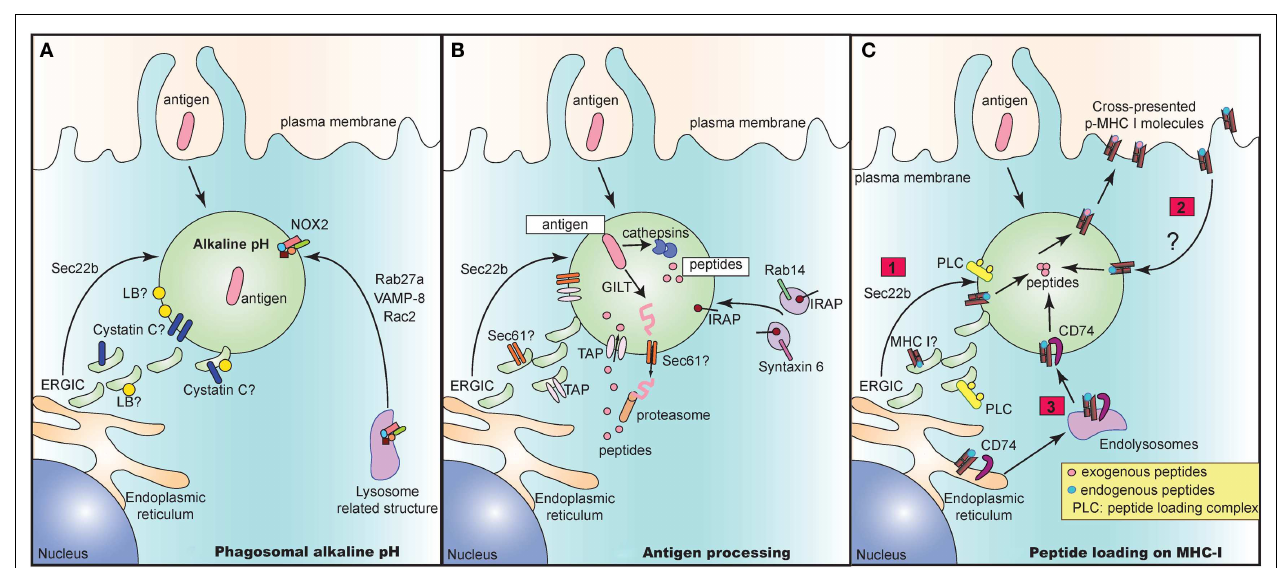
could be present in ERGIC, thereby recruited to the cross-presenting compartment via Sec22b. Once in the cytosol, antigen is then degraded into peptides and shuttled back into the phagosome via phagosomalTAP.TAP is dependent on Sec22b for its recruitment from ERGIC to endocytic compartments. Finally, IRAP, which is present on Rab14 + and Syntaxin 6 + endosomes, is recruited to phagosomes and mediates trimming of imported peptides that are further optimized for cross-presentation. (C) Lastly, processed and trimmed peptides have to now be loaded onto MHC